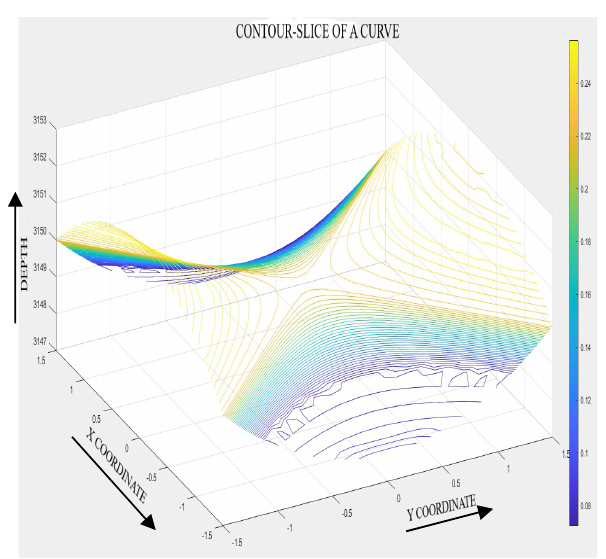
Figure 8. Contour slice of the curved surface(of figure 7.) showing porosity variation (displayed on colour-bar). Variation in the petrophysical quantities can be visvalised across the reservoir, within the considered dimensions of meshgrid. Figure 6,7,8 depict the variation for a curved surface while figure 9. displays variation for a plane surface. Figure 9. has the following specifications: X, Y: (-1.5,1.5), step of 0.1 km Z: ((X + Y) +3200).